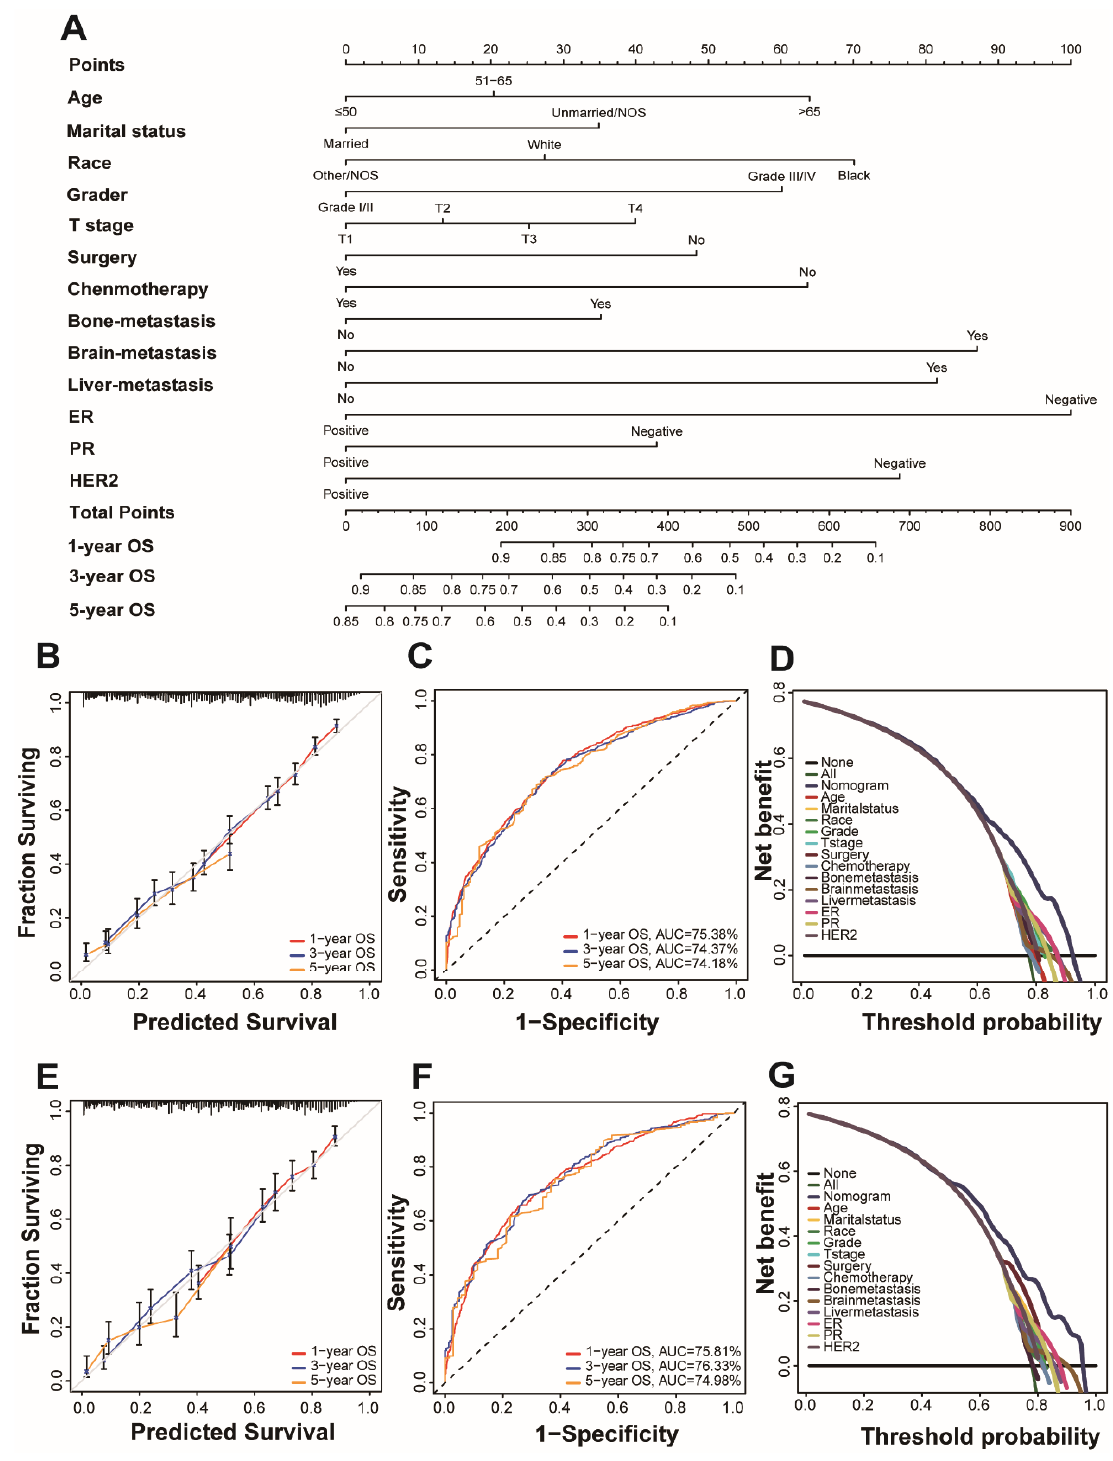
Figure 2. Nomogram and model assessment for predicting 1-, 3-, and 5-year overall survival (OS) in BCLM patients. ( A ) The OS nomogram for BCLM patients. The calibration plots in the ( B ) training and ( E ) validation cohorts for 1-year, 3-year, and 5-year OS. AUC values of ROCs of the nomograms for 1-year, 3-year, and 5-year OS. The values in brackets B and E represent the area under the ROC curves (AUC). ( C ) for the training cohort and ( F ) for the validation cohort. Decision curve analyses (DCA) of the nomogram and other factors’ overall survival. ( D ) for the training cohort and ( G ) for the validation